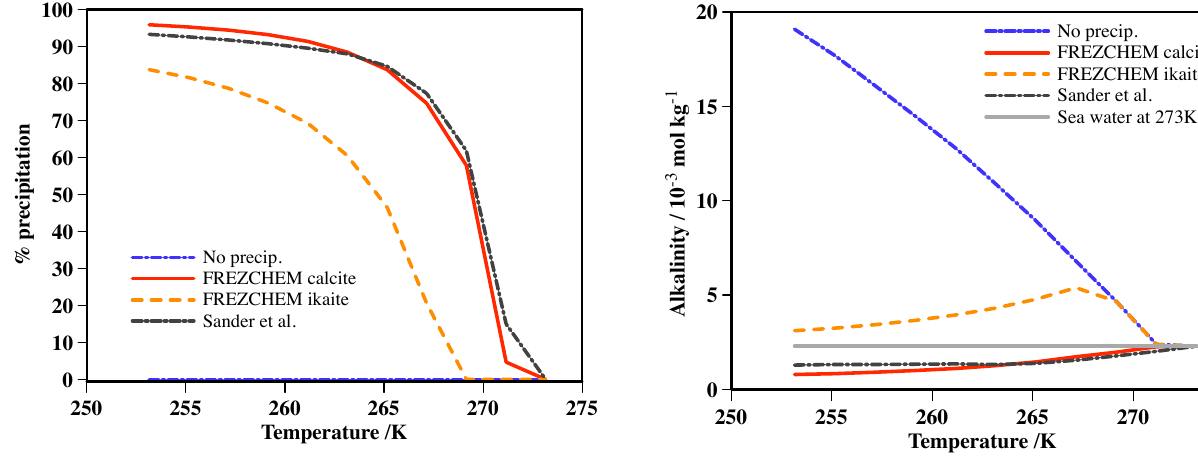
Fig. 2. Alkalinity A T of the brine during the freezing of sea wa- ter. The definition is A T = m (OH − ) + m (HCO − + 2 m (CaCO ◦ 3 ) + 2 m (MgCO ◦ 3 ) − m (H + ) , where CaCO ◦ 3 and MgCO ◦ 3 represent dissolved ion pairs.